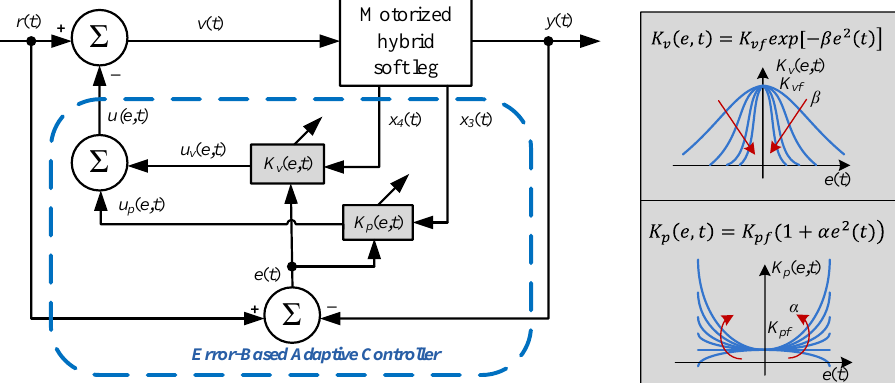
. x 3 ( t ) , and the change of